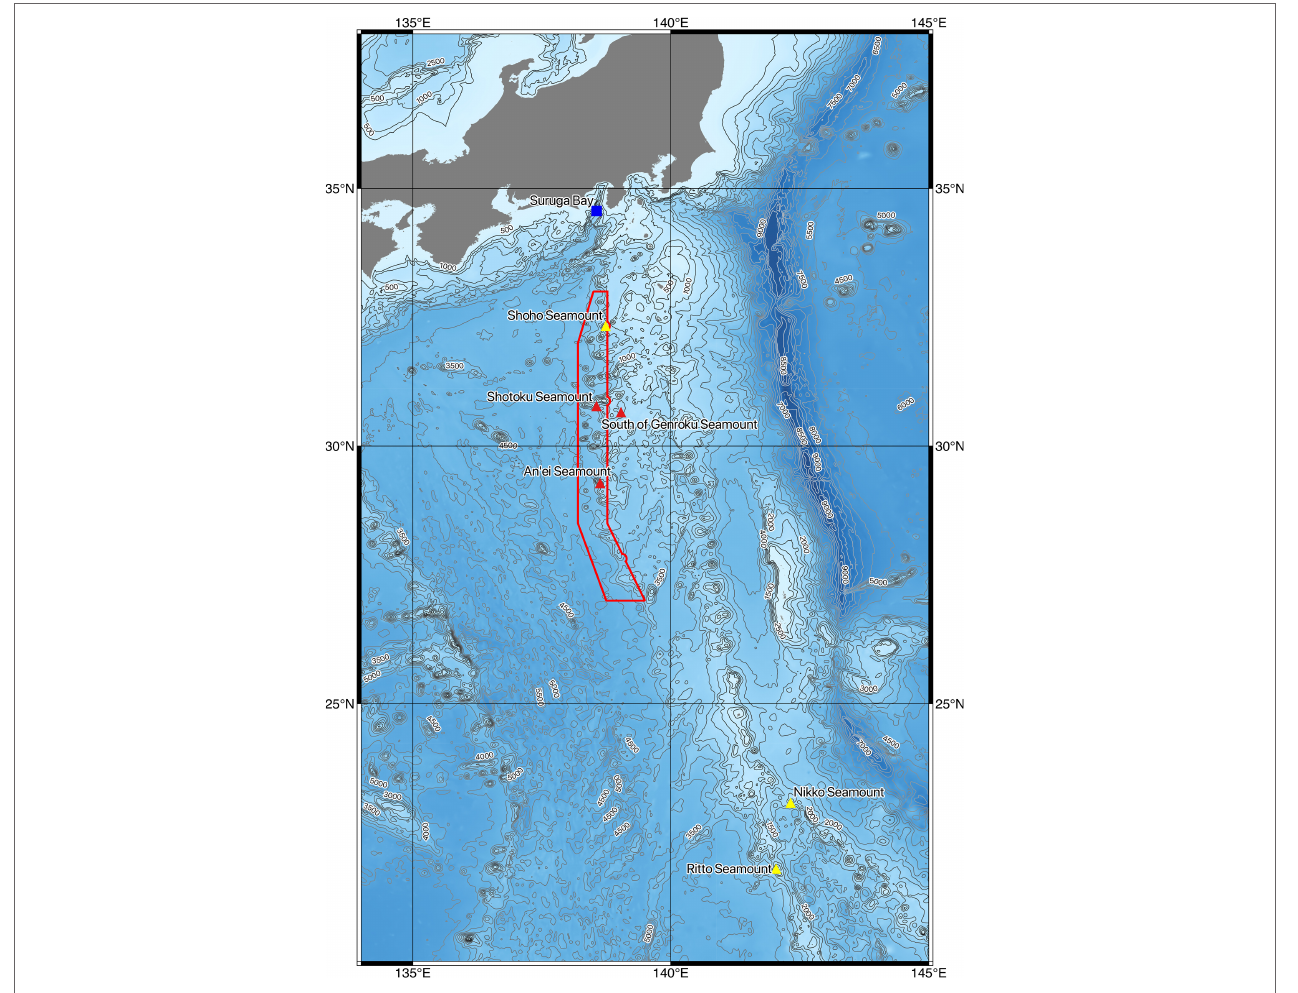
FIGURE 1 | Research area and location of CTD casts and baited camera deployments. This map was created using QGIS software version 3.10 (https://qgis.org/), and bathymetric data etopo1 (doi:10.7289/V5C8276M) was supplied by the NOAA National Geophysical Data Center. Triangle: research locations; red triangle: Yokozuna Slickhead ( Narcetes shonanmaruae )-positive sites; yellow triangle: Yokozuna Slickhead-negative sites; blue square: type locality of Yokozuna Slickhead; red box: the Nishi-Shichito Ridge Marine Protected